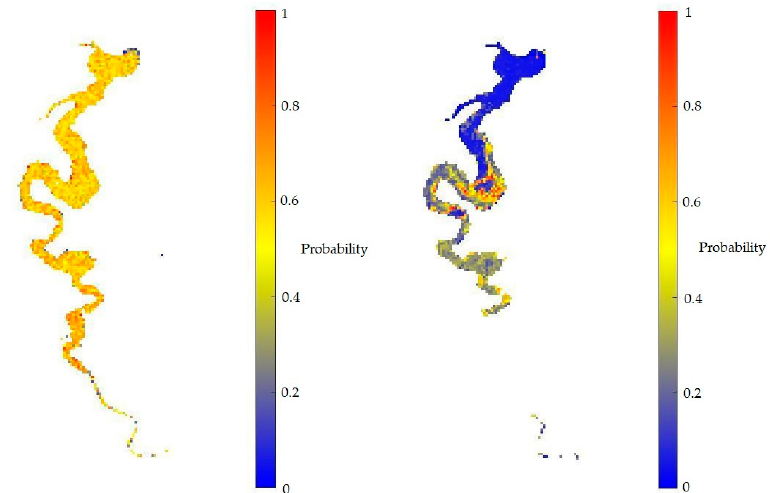
Figure 9. Biomass prediction-based fish occurrence probability map for Landsat 5 validation image (left—29 July 2008) and Landsat 8 validation image (right—20 August 2016).